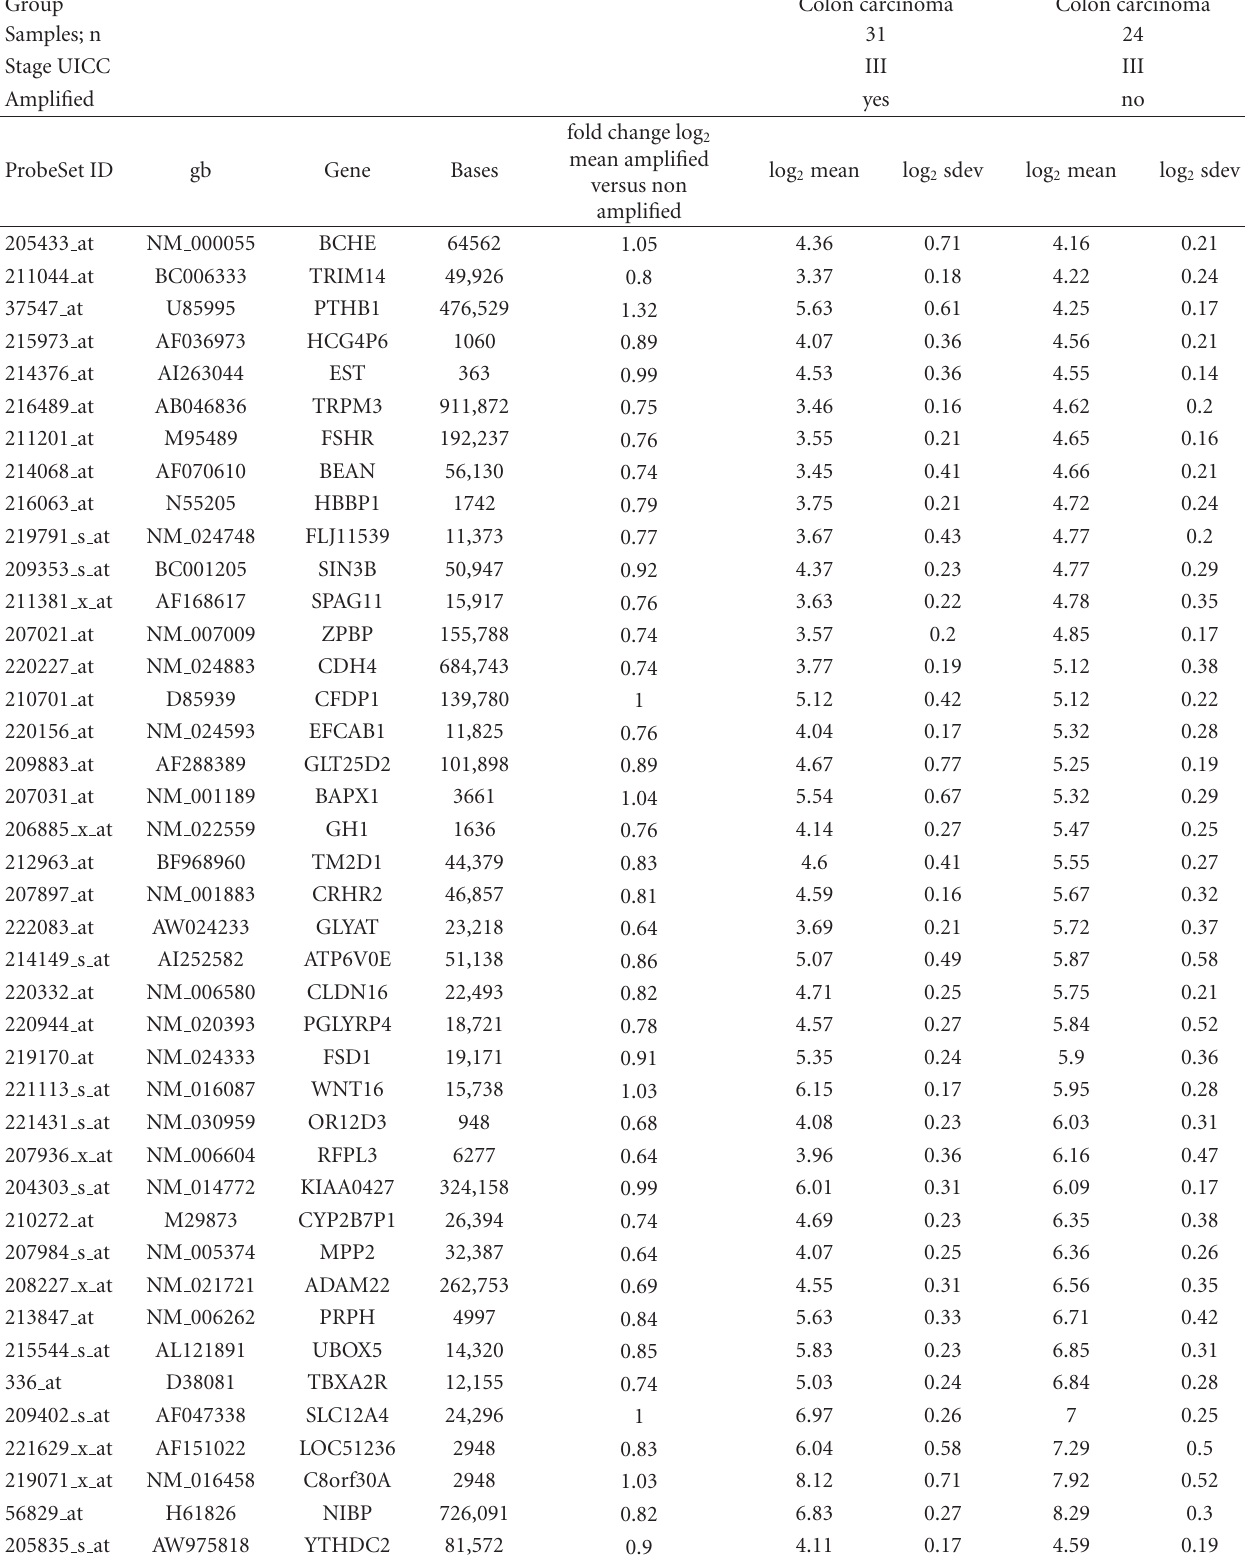
Table 3: Comparison of mean signals and standard deviation (sdv) of genes which were recently described as predictive for lymphatic metastasis in colorectal carcinomas [12], between 31 amplified RNA samples of colon carcinomas and 24 RNA samples of colon carcinomas not amplified prior to microarray